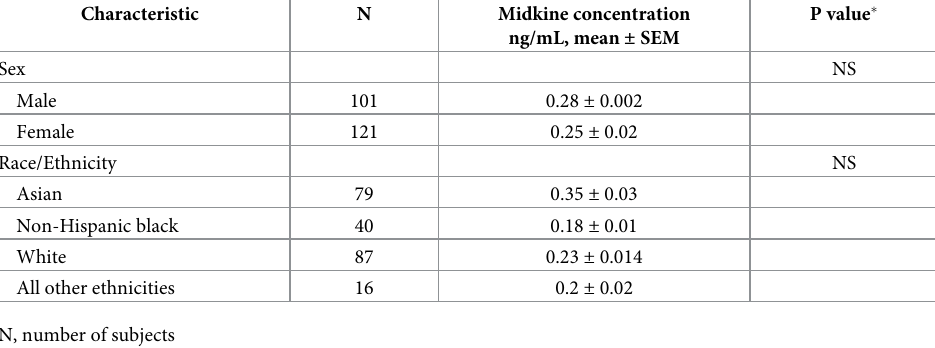
Table 2. Association between plasma MDK concentrations and sex, race/ethnicity, BMI SDS and height SDS in healthy children.